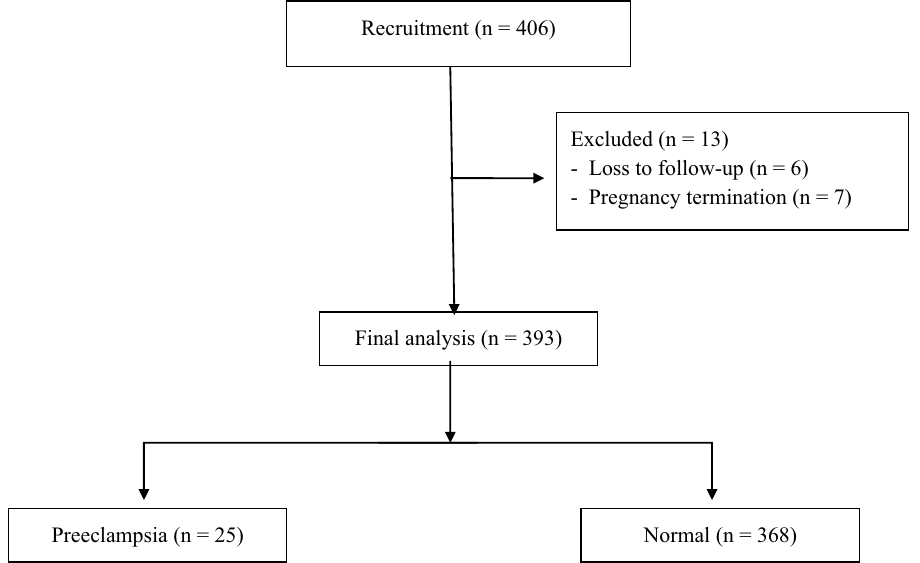
Figure 1. Recruitment flowchart for study participants.